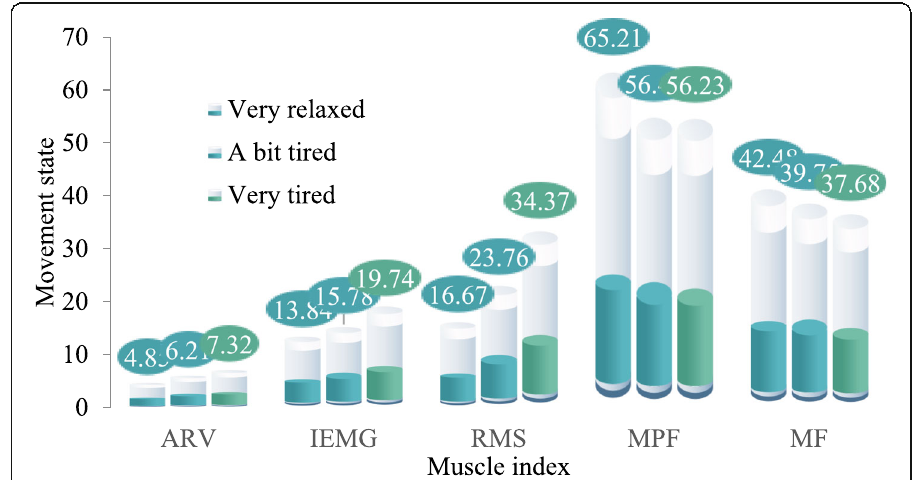
Fig. 2 Straight femoral electromyography indicators of different exercise